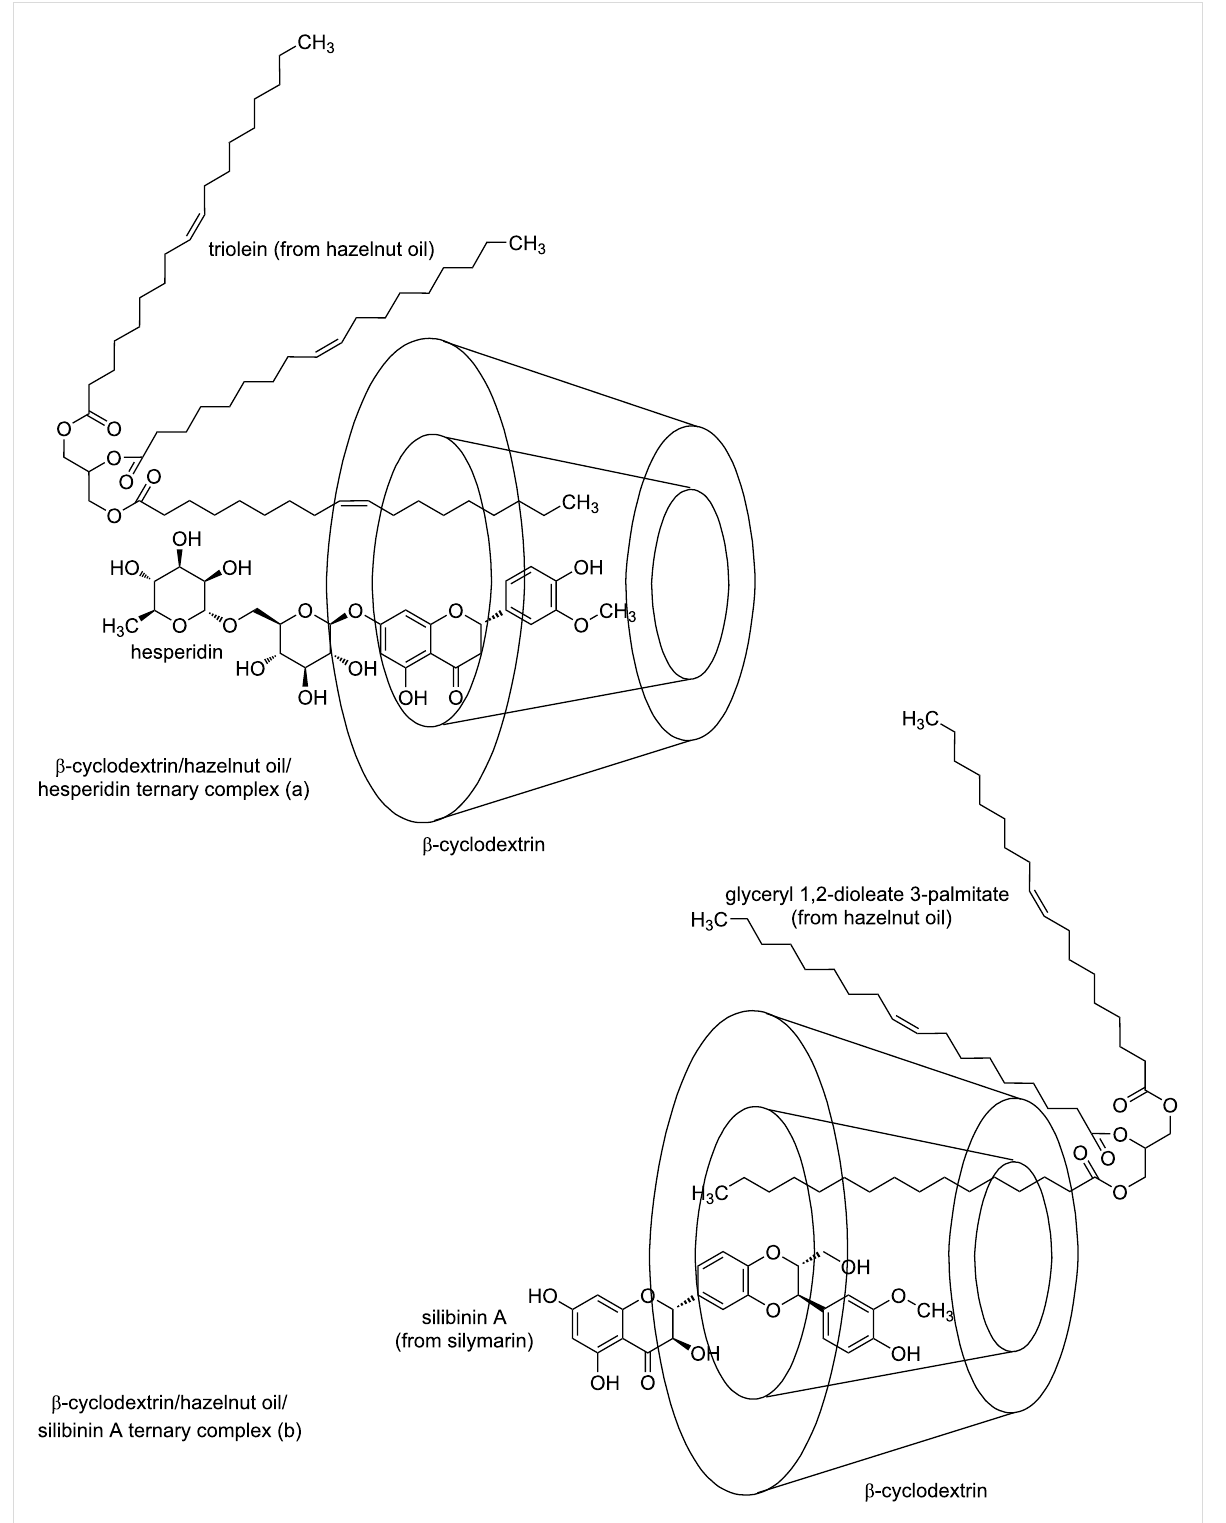
Figure 1: Hypothetical interactions between the β -cyclodextrin host and guest molecules (flavonoid glycoside/flavonolignan and a fatty acid triglyc- eride from the hazelnut oil), not explicitly proven in this study. (a) Both triolein from hazelnut oil and hesperidin interact with β -cyclodextrin from the secondary face; (b) glyceryl 1,2-oleate 3-palmitate from hazelnut oil interacts with the β -cyclodextrin from the primary face, while silibinin A, the main component of silymarin, interacts with β -cyclodextrin from the secondary